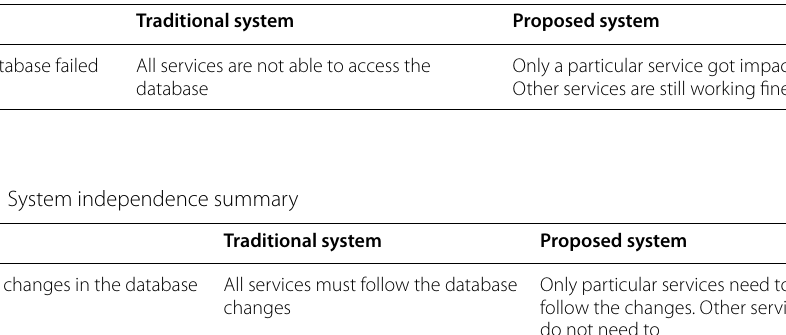
Table 6 System resilience summary